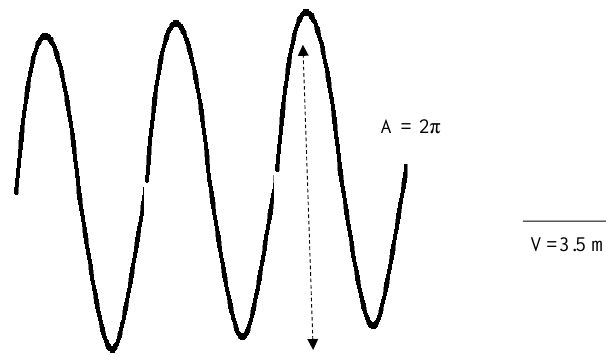
Figure 16. Static pressure distribution over flapping flat plate at t = 0.001. Owing to the tugging effect of the near wall shear, upon a close encounter of the flow with the body and due to the gradual development plus external compression of the growth of the boundary layer by surrounding pressure, it can be noted that the incoming